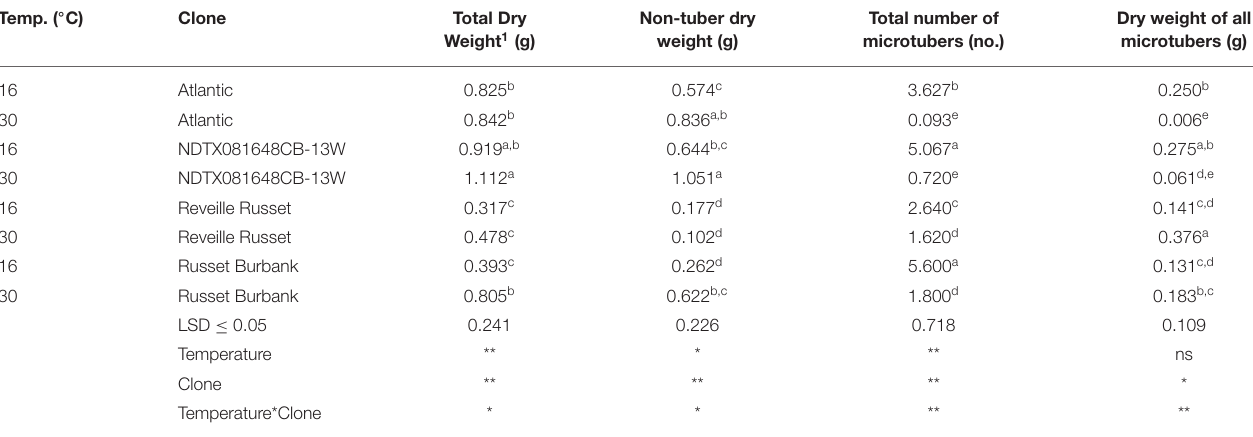
TABLE 3 | Effect of temperature on growth and microtuber yield (per explant) of potato clones in temporary immersion bioreactor bioreactors (first bioreactor trial). Temp. ( ◦